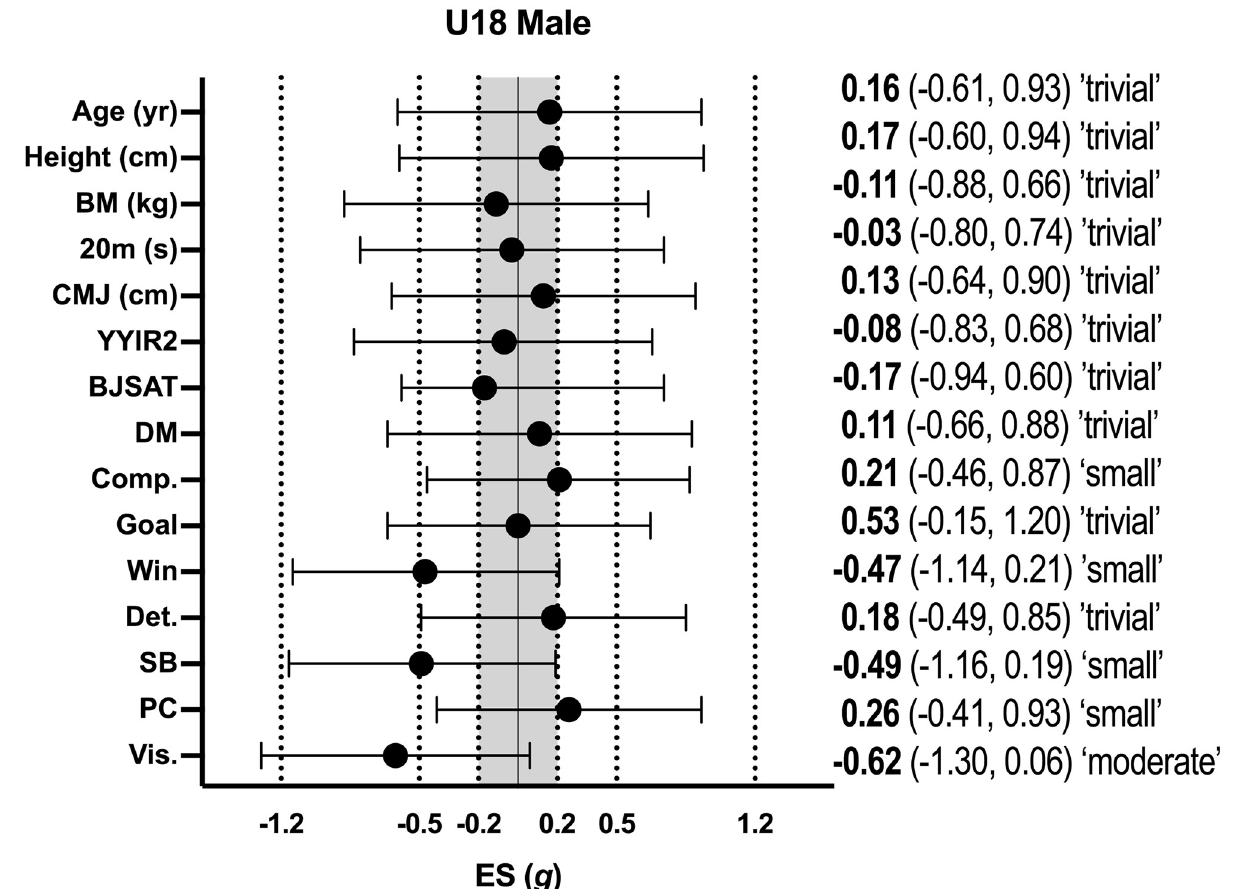
Fig 2. Effect sizes between selected and non-selected male U18 basketballers. BM–body mass; CMJ–countermovement jump; YYIR2 –Yo-Yo Intermittent Recovery Test Level 2; BJSAT–Basketball Jump Shooting Accuracy Test: DM–decision-making; Comp–competitiveness; Det.– determination; SB–self-belief; PC–positive cognition;